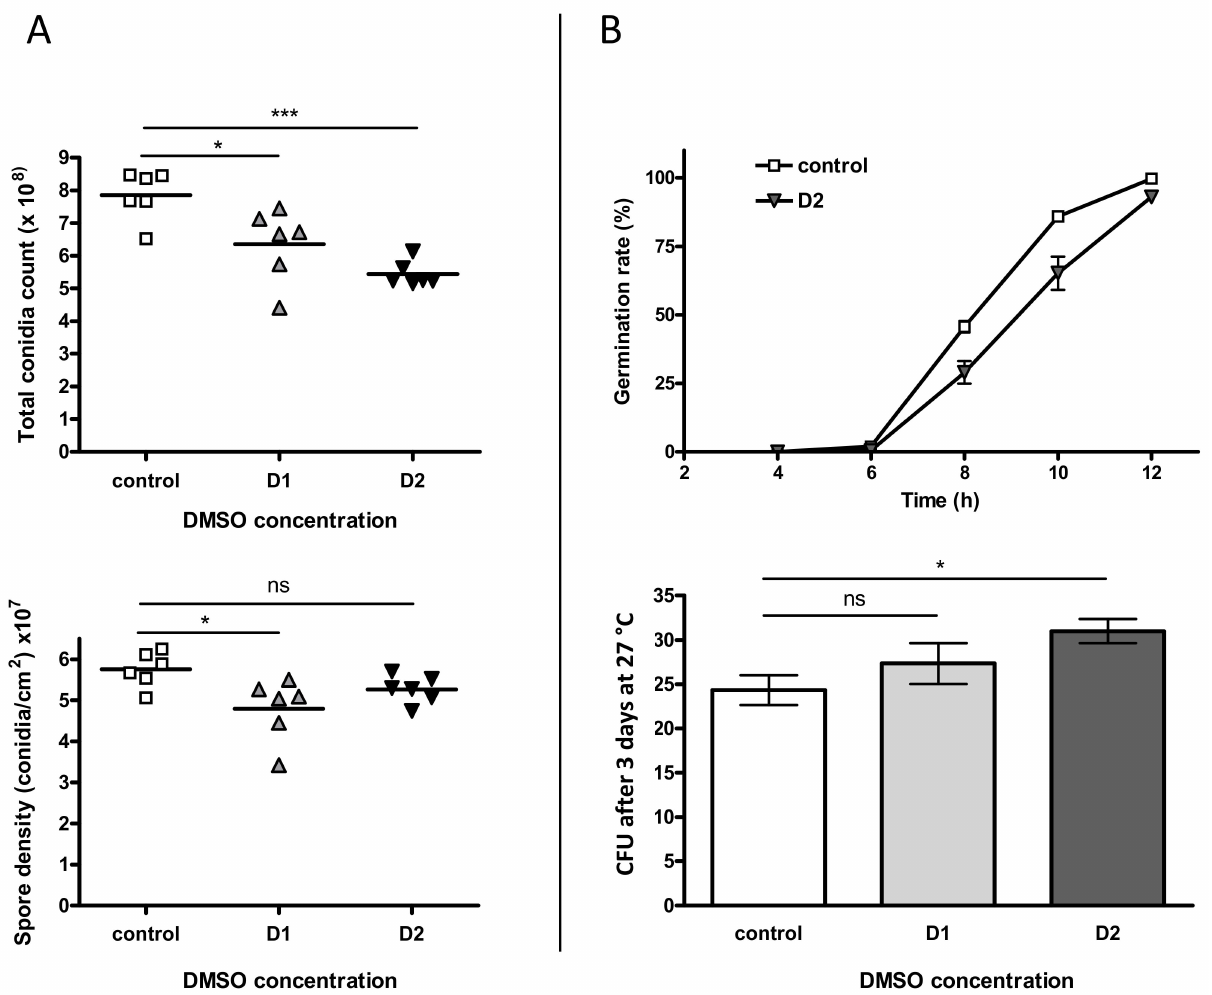
Figure 3. Impact of DMSO on both sporulation and germination of Aspergillus flavus . ( A ) The top-graph represents the total amount of spores in a 4-day colony after incubation at 27 ◦ C in the dark. The bottom-graph shows the spore density (after normalization with colony area). In both graphs controls are represented with squares, D1-treated cultures with triangles and D2-treated cultures with inverted triangles. ( B ) Germination was studied at two scales: germination rate (top-graph) was examined microscopically for MEA (control) and MEA + 281.6 mM DMSO (D2). Germination capacity (bottom-graph) is corresponding to the CFU number after plating and incubating 60 theorical spores; ns = no significant difference; * p < 0.05 *** p <